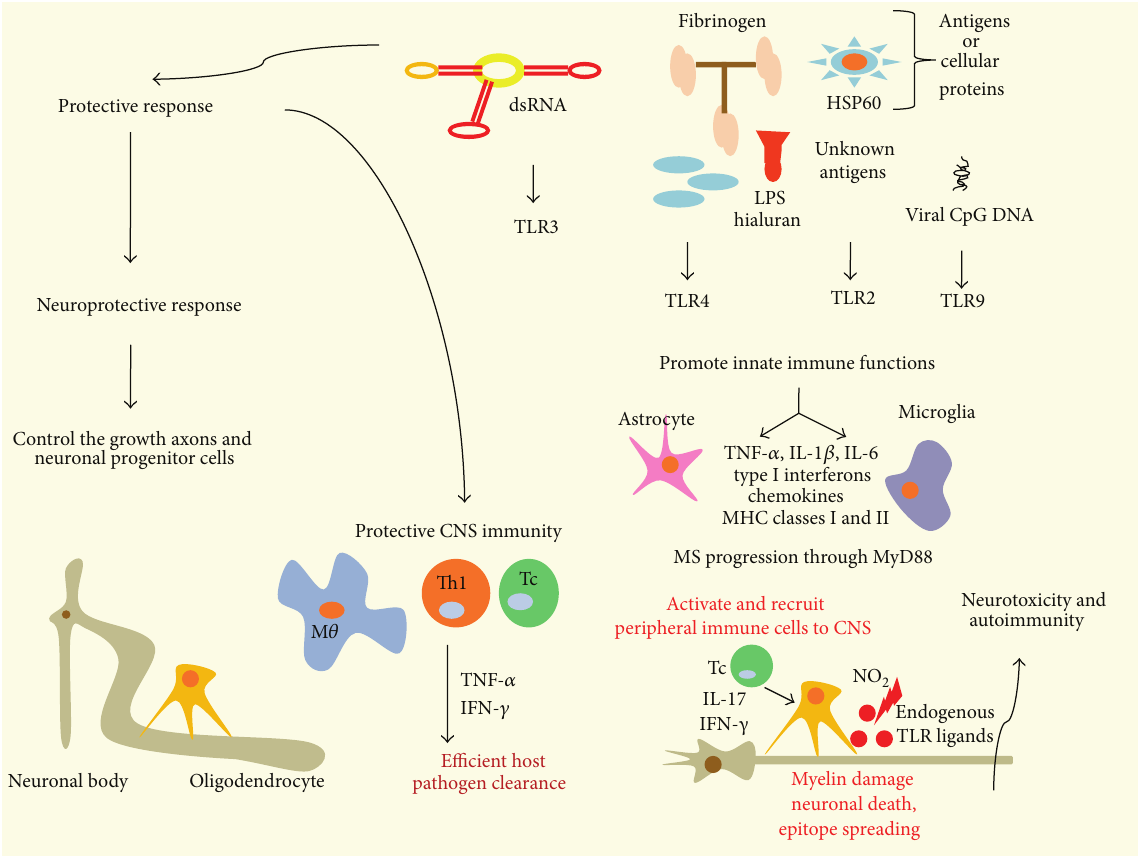
Figure 1: Role of innate immunity in multiple sclerosis. Glial cells, astrocytes, and microglia express a wide variety of TLRs. Stimulation with TLR ligands, dsRNA (TLR3), LPS (TLR4), peptidoglycans (PGN; TLR2 with TLR1/6), and viral CpG DNA (TLR9), promotes an array of immune functions in glial cells, including the secretion of proinflammatory cytokines, chemokines, type I interferons (IFN- 𝛼 / 𝛽 ), and an increase in MHC classes I and II expression. TLRs activate macrophages, microglia, and dendritic cells (DCs) resulting in the production of cytokines of the innate immune system such as IL-6, IL-1 𝛽 , and TNF 𝛼 . These cytokines participate in blood brain barrier disruption and lymphocyte attraction to sites of inflammation, promote inflammation, and modulate adaptive immunity. For instance, IL-6 promotes Th17 and B cell differentiation. Th17 and Th1 cells and inflammation will contribute to tissue damage. Finally, MG, microglia, and DC also secrete IFN 𝛽 which, among other immunomodulatory functions, prevents leukocyte adhesion and extravasation across the blood brain barrier. Modified by Carpentier et al.